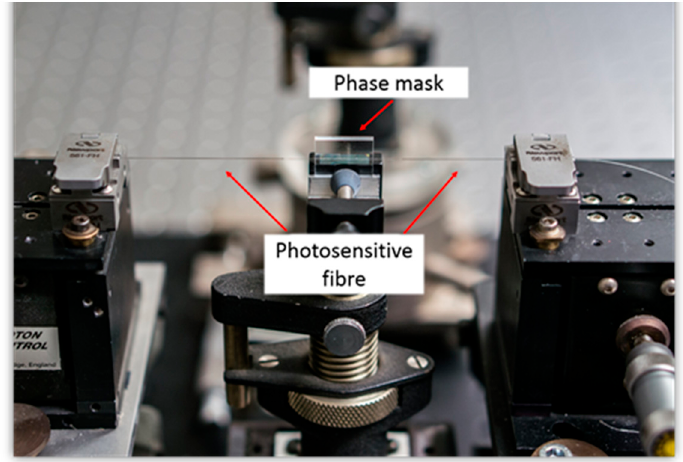
Figure 8. Phase mask setup for FBG manufacturing.